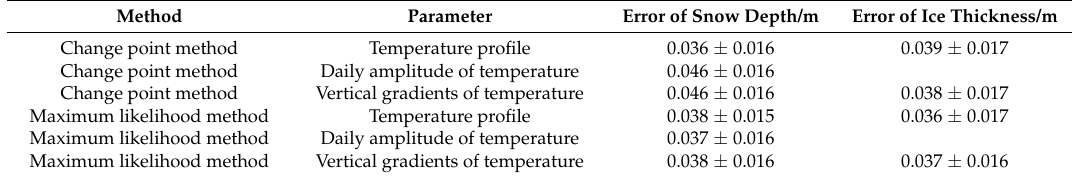
Figure 8. The statistical errors of snow depth (top interface) and ice thickness (lower interface) of the change point detection method and maximum likelihood detection method using temperature profiles ( a , b ), daily change of temperature ( c ), and vertical gradients of temperature ( d , e ). Table 2. Results of the two methods. Table 2. Results of the two methods.